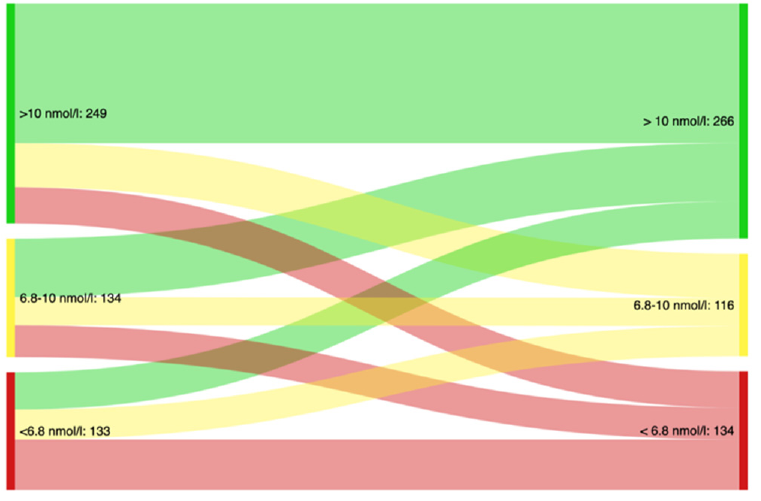
Figure 1. Movement between folate status categories from the first to the second serum folate assessment. Figure 1 displays the movement between folate status categories from the first (left) to the second (right) folate assessment for participants with at least two serum folate measurements (n = 516). It shows that 63% (CI: 57–69) of participants with an adequate serum folate status, 60% (CI: 53–65) of those with low levels and 43% (CI: 34–51)